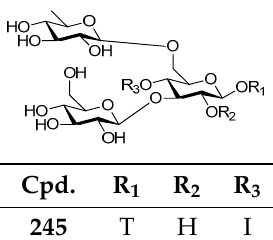
Figure 50. Structure of compound 244 .